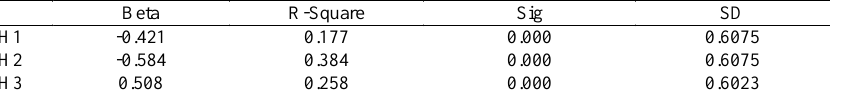
Table 2: Beta test, R-Square, Sig and Standard Deviation